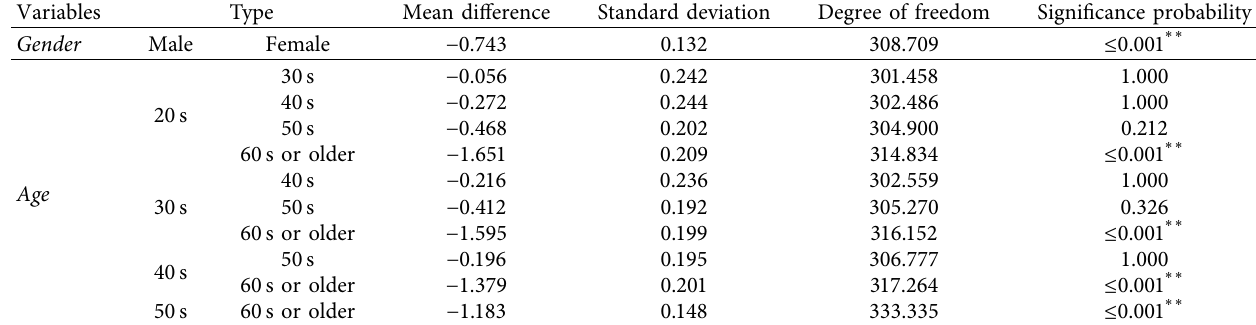
Table 18: Pairwise test results among genders and ages on takeover time.